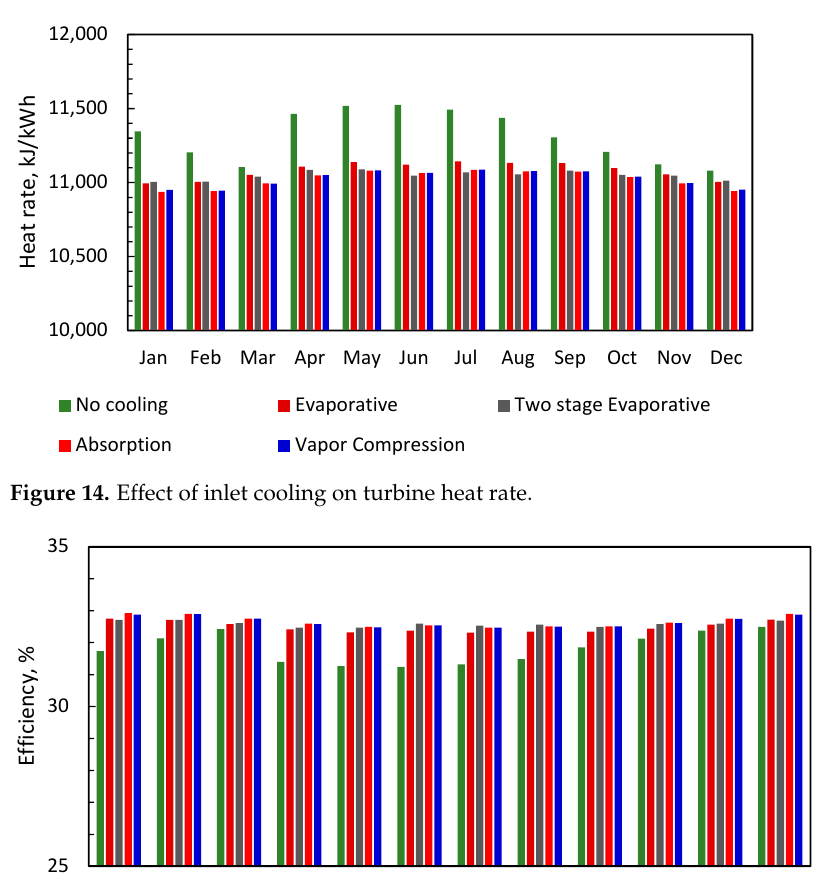
Figure 16. Percentage increase in gas turbine efficiency. Water consumption for inlet cooling systems is critical in dry regions. For simulated inlet cooling systems, water is needed to operate evaporative cooling sections and cooling towers. Figures 17 and 18 show the total water consumption using evaporative coolers and cooling towers at daily and yearly rates. The two-stage evaporative cooling system consumes less water than the hybrid absorption and vapor-compression systems. The cooling tower of the absorption refrigeration system consumes larger amounts of water than other systems to release high condenser heat to the surrounding. The hybrid absorp- tion system needs 80%, 130% and 240% more water than the hybrid vapor-compression, the two-stage evaporative and the evaporative TIAC systems, respectively. Figure 19 shows that the fuel consumption of the gas turbine with inlet cooling sys- tems increases, compared with the gas turbine without a cooling system. The increase in fuel consumption is related to the increase in the compressor airflow rate owing to inlet cooling. Figure 20 shows the annual increase in fuel consumption. ∆(cid:1865) (cid:3033) = (cid:1865) (cid:3033),(cid:3036)(cid:3030) − (cid:1865) (cid:3033),(cid:3050)(cid:3036)(cid:3030)